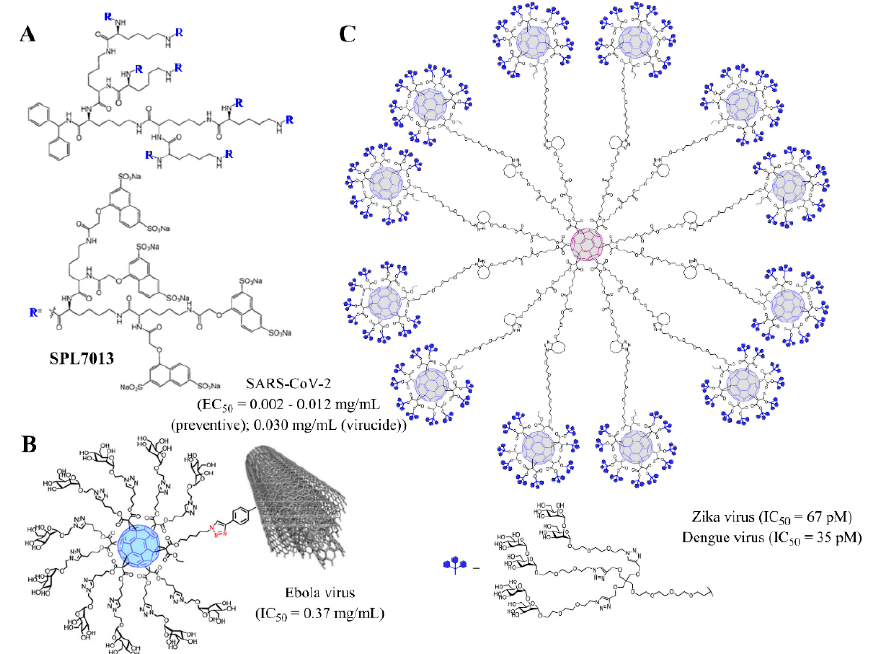
Figure 5. Examples of dendritic materials with potent antiviral activity and representative EC 50 / IC 50 values. ( A ) SPL7013 dendrimer (VivaGel ® ), against SARS-CoV-2; ( B ) dendronized glycofullerene conjugated to multiwall carbon nanotubes, towards Ebola virus; ( C ) dendronized glycofullerene nanoballs, efficient towards Zika and Dengue viruses. Reprinted with permission from Refs. [84] ( B ) and [85] ( C ), Copyright 2018 and 2019, American Chemical Society.